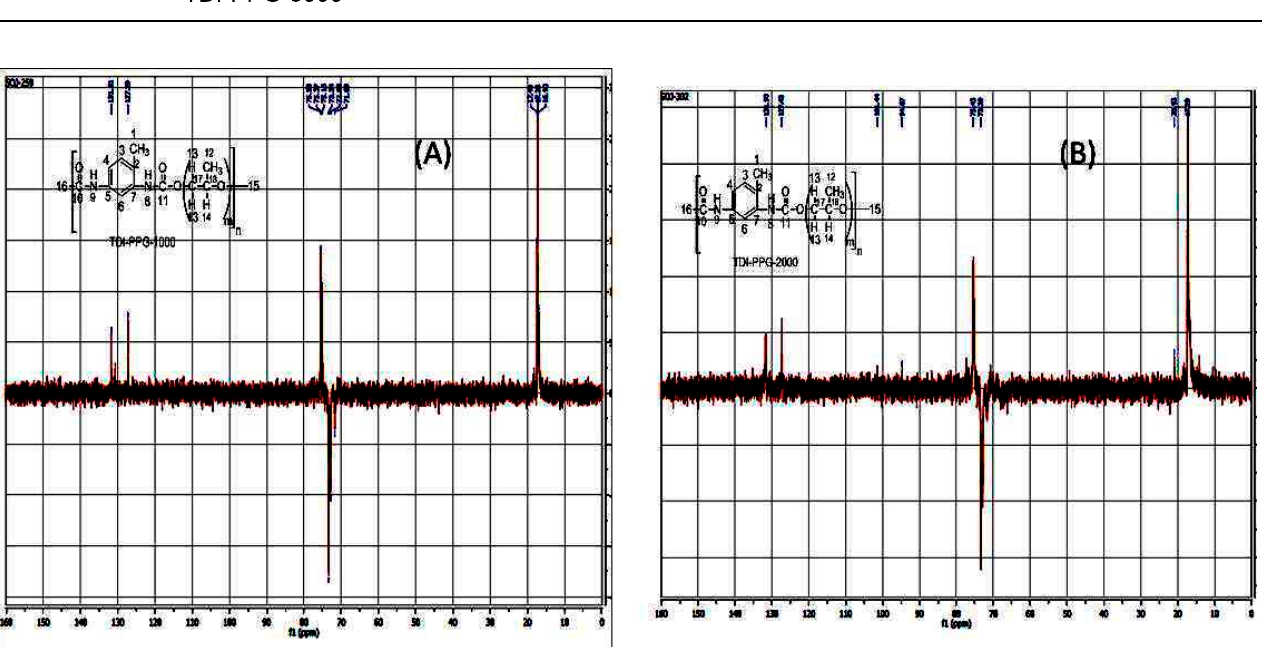
Figure 3. DEPT-135 spectra of ( A ) TDI-PPG-1000 and ( B ) TDI-PPG-2000.